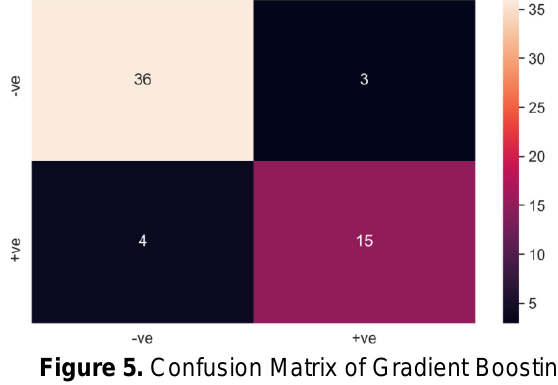
Figure 5. Confusion Matrix of Gradient Boosting